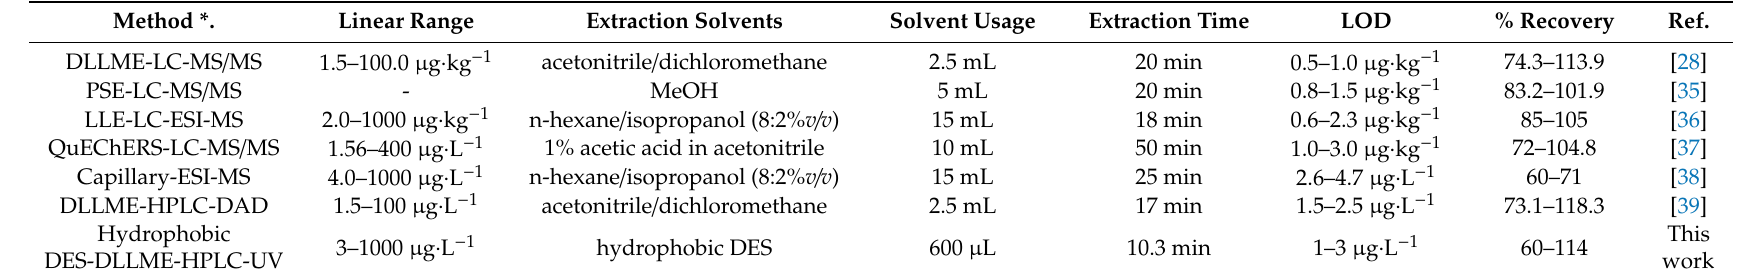
Table 2. Comparisons of the proposed method with other methods for the quantitation of neonicotinoid insecticides. Method